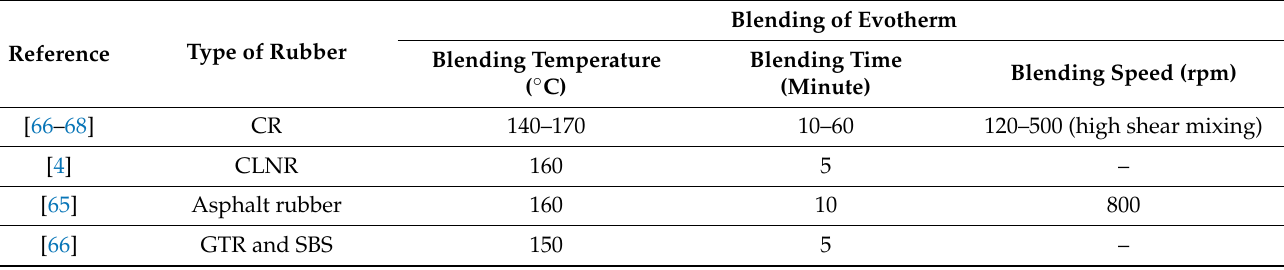
Table 7. Method of Evotherm application based on previous